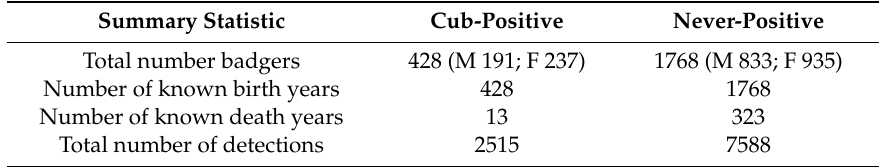
Table 2. Summary of capture-mark-recapture data sets describing badgers in one of two health states: “cub-positive” (badgers that tested positive in the first year of their lives) and “never-positive” (badgers that have never tested positive throughout their lives). Known birth years refers to cubs captured and identified as being within the first year of their lives. Known death years refers to badgers who were recovered dead and subjected to post-mortem. Detections are the total number of capture events that took place over the duration of the study.